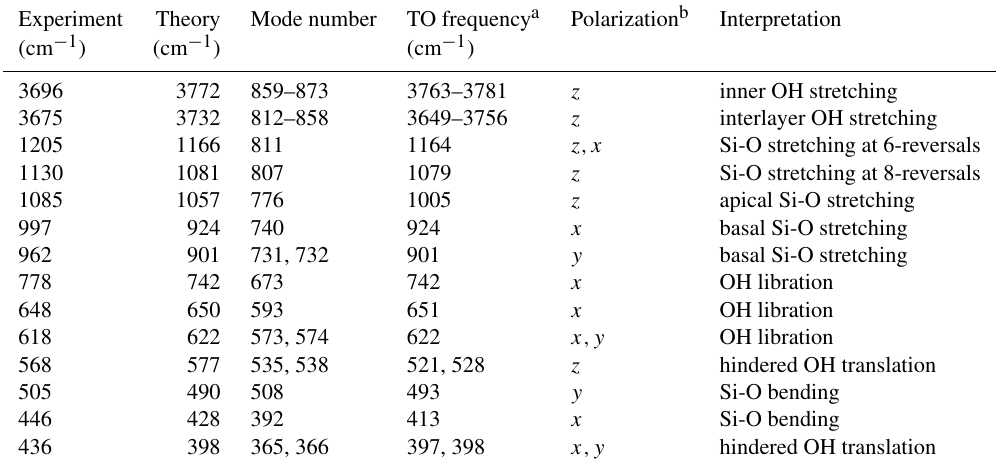
Figure 2. Experimental (top) and theoretical (bottom) IR absorption spectra of antigorite: (a) OH-stretching region, (b) mid-IR range. The major features of the experimental and theoretical spectra are indicated by their wavenumber. The theoretical spectrum is computed for a (001) plate inserted in a KBr matrix. Table 1. Interpretation of experimental absorption bands. The mode number refers to the Supplement.